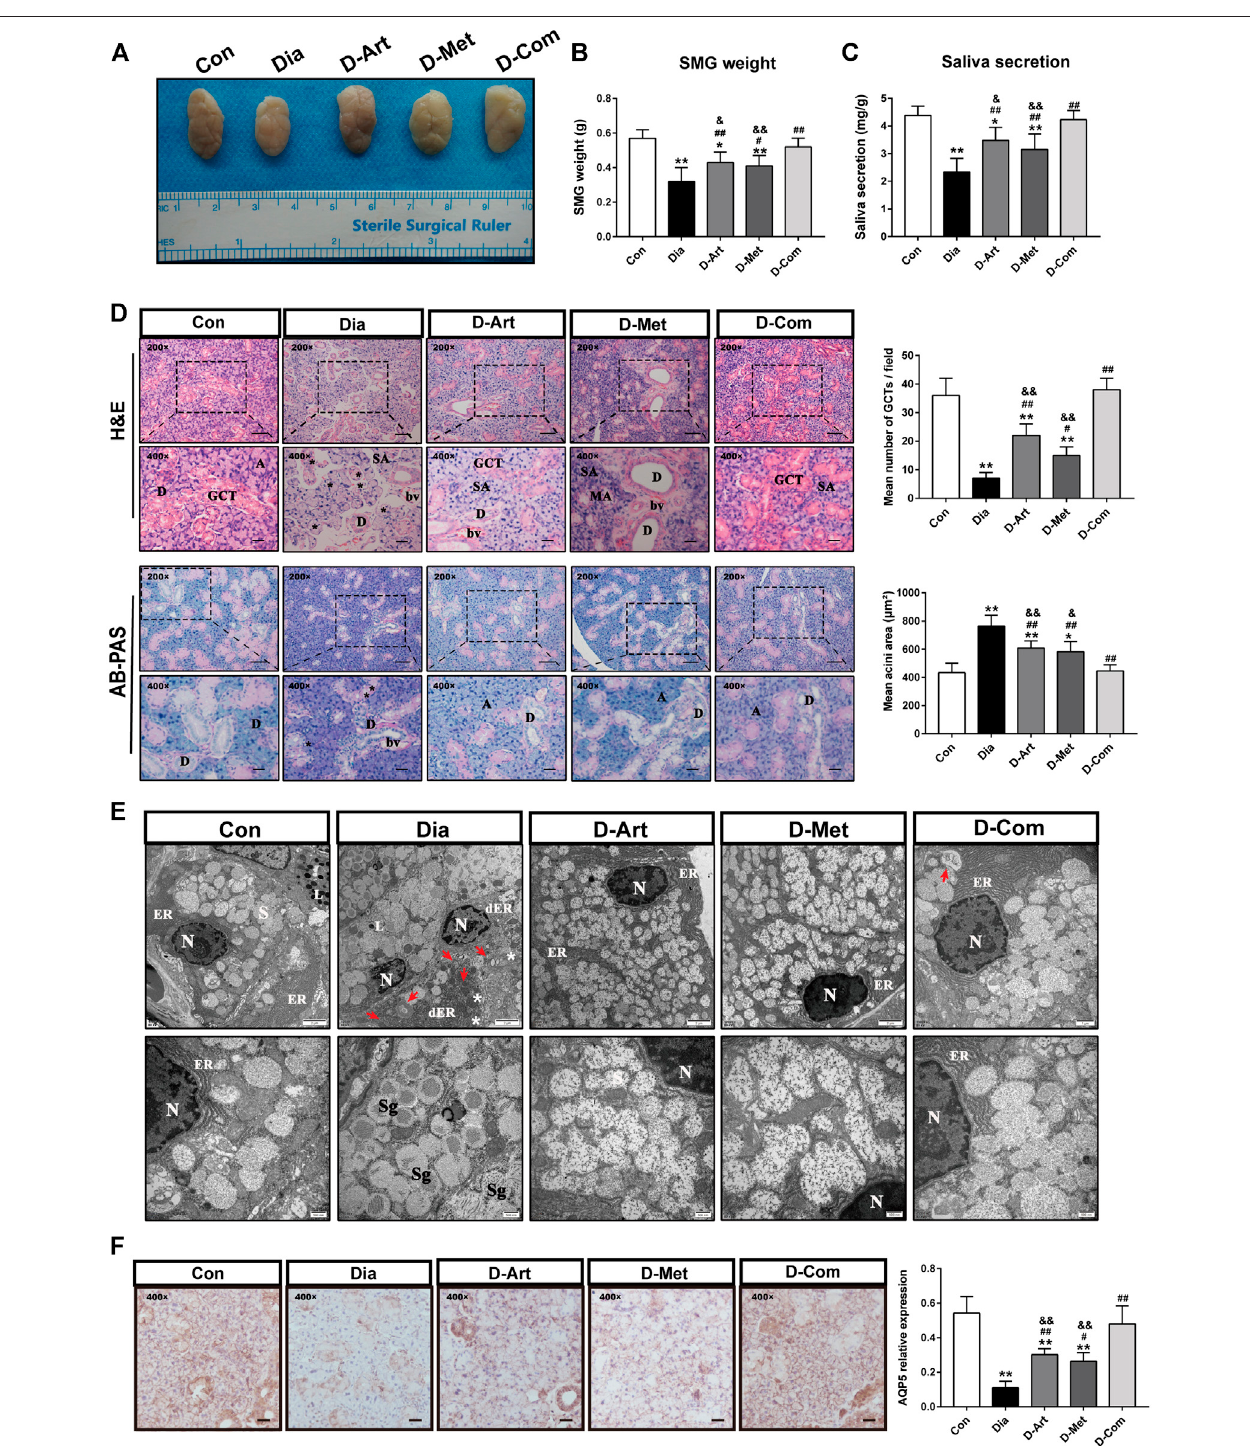
FIGURE 4 | ART or Met alone and ART/Met combination mitigate SGs ’ dysfunction and pathological alterations in the T2DM rats. (A) Gross morphology and (B) weightofSMGsineachgroup. (C) Salivasecretionofratsineachgroup(8ratspergroup). (D) H&EandAB-PASstainingofSMGsineachgroup(5ratspergroup),scale bar (cid:1) 50 μ m (200 × ); scale bar (cid:1) 20 μ m (400 × ). A, acini; SA, serous acini; MA, mucous acini; D, duct; GCT, granular convoluted tubules; bv, blood vessel. Vacuolation is labeled using black*. (E) Ultrastructure of SMGs in each group. N, nucleus; ER, endoplasmic reticulum; dER, disrupted endoplasmic reticulum; L, Lysosome; Sg, secretory granules. White * represent swollen and disrupted mitochondria and red arrows represent autophagosomes. (F) Immunohistochemistry analysis of AQP5